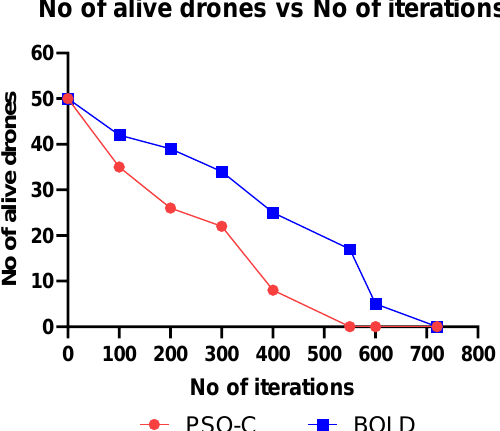
Figure 14. Number of alive drones vs iterations.